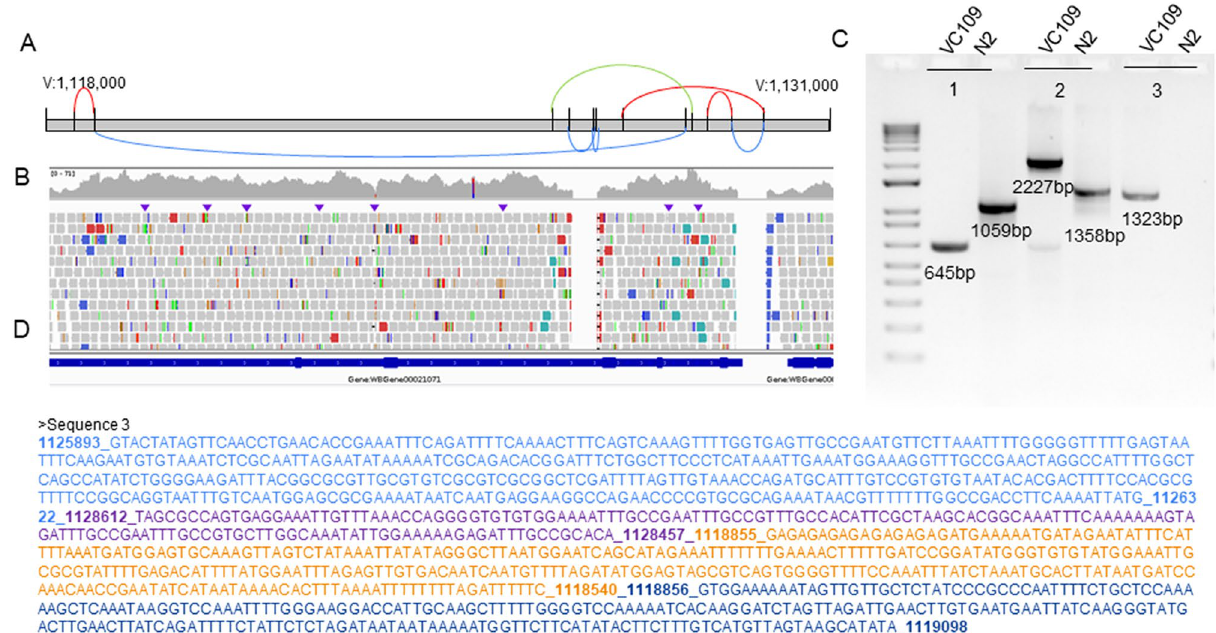
Figure 3. Complex rearrangement in eT1 strains on LGV. ( A ) Schematic representation of the complex rearrangement combining three inverted tandem duplications (red), four deletions (blue), and one inversion (green) along LGV around 1.1 Mb. ( B ) IGV screenshot of the VC109 genome ( unc-36 ) for the region overlapped by the complex rearrangements. ( C ) PCR gels. 1 = Deletions V:1,126,582–1,126,983 and V:1,127,007–1,127,020; 2 = Deletion V:1,129,264–1,129,753, inverted tandem duplication V:1,127,471–1,129,752 and inverted tandem duplication V:1,128,827–1,129,264. 3 = Deletion V:1,118,855–1,128,457, inverted tandem duplication V:1,118,539–1,118,853, and inversion V:1,126,322–1,128,612. ( D ) Sanger sequencing of the PCR product #3 confirming several breakpoints.